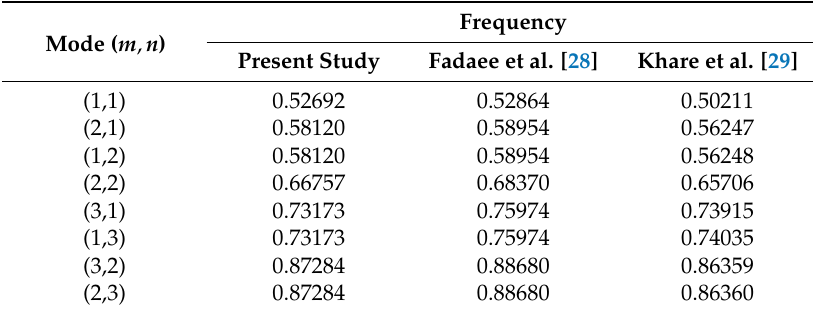
Table 2. Comparison of the circular frequencies (rad/s) for an isotropic simply-supported (SSSS) spherical